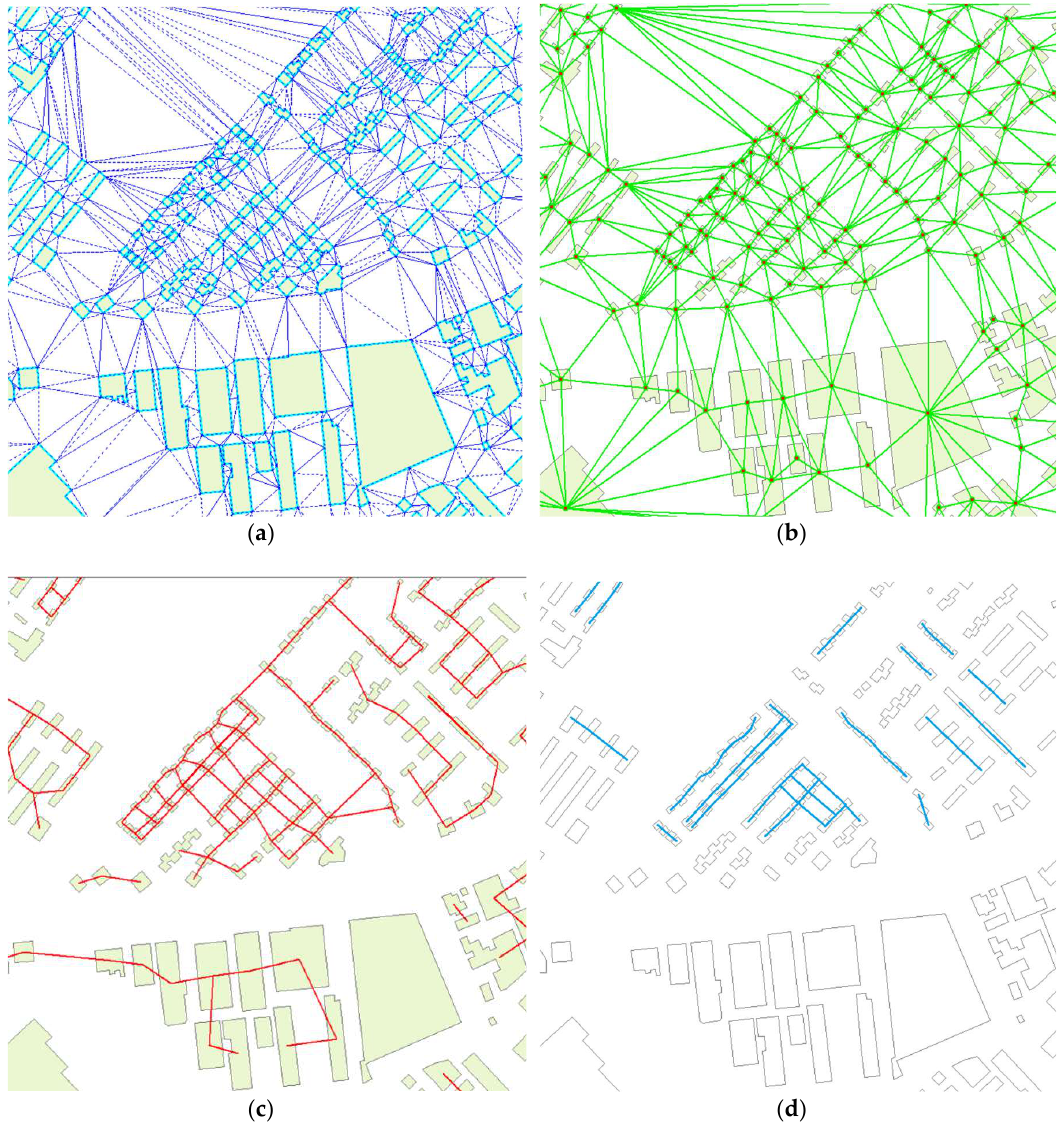
Figure 9. Steps in recognizing the building alignments: ( a ) computing Delaunay triangulation (DT) on building footprints, ( b ) derived proximity graph, ( c ) pruned proximity graph, and ( d ) recognized